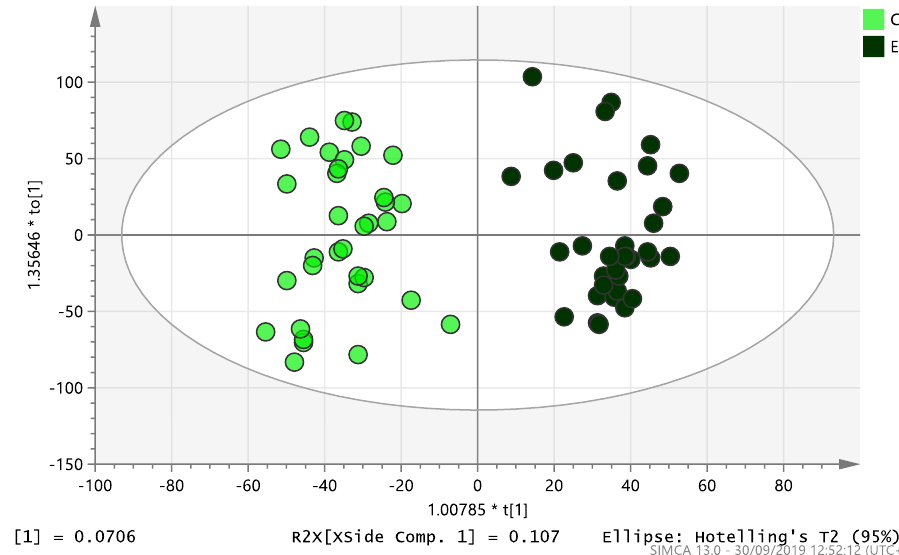
Figure 3. Multivariate analysis based on all detected ions from endometrial tissue samples: OPLS-DA score plot of control (C, n = 34) and endometrial cancer (E, n = 34). R2X(cum) = 0.195 and Q2(cum) = 0.583.